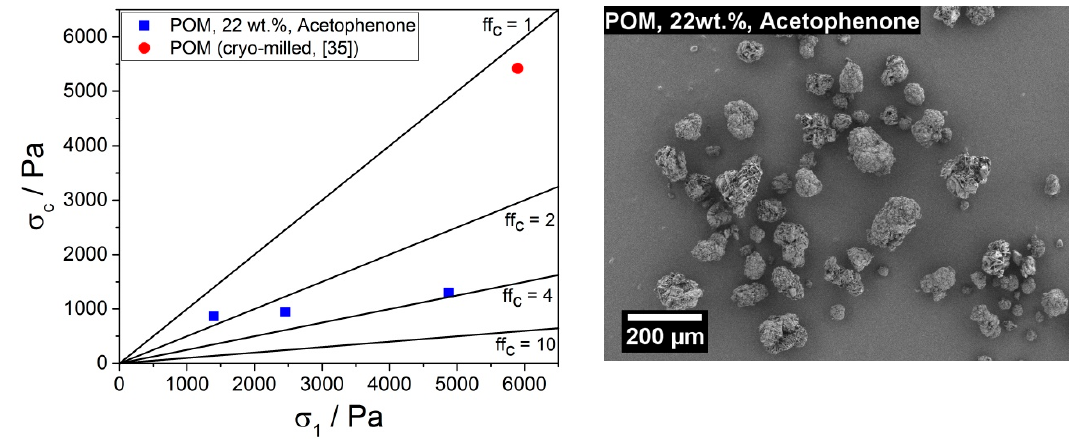
Figure 6. Left: Flowability ff c , as determined with ring shear experiments, of the manufactured POM PBF feedstock (blue squares) in comparison with the cryo-milled POM reference (red circle). Right: SEM image of the precipitated POM particles.